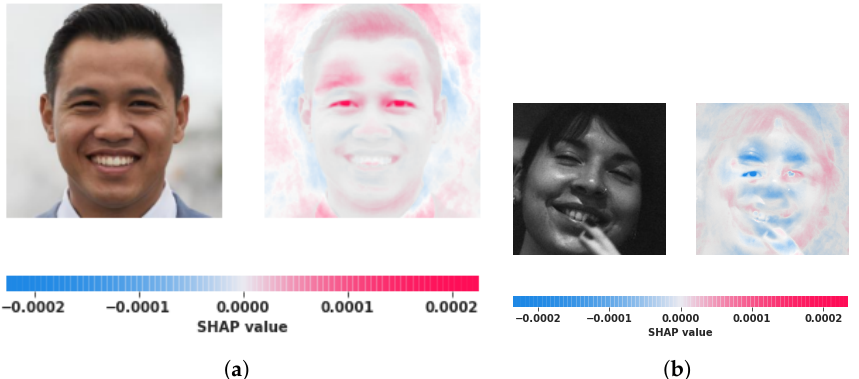
Figure 4. Considering fake and real categories, ( a ) shows the SHAP results for a fake image, whereas ( b ) shows the SHAP results for a real image .